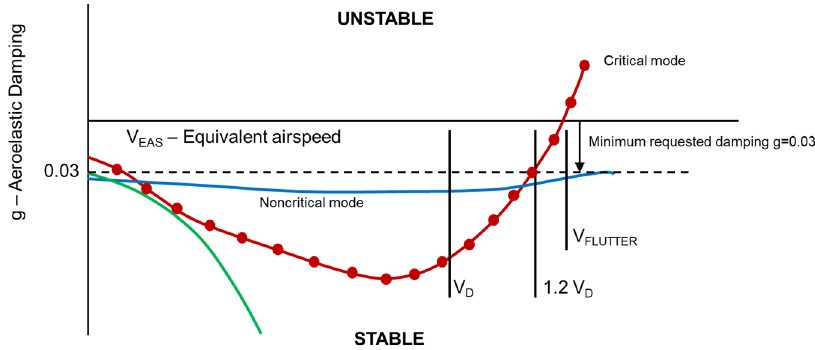
Figure 5. Formulation of fl u tt er constraint.